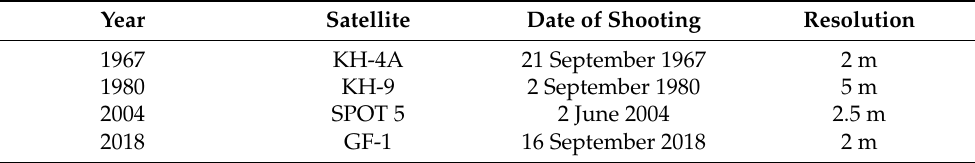
Table 1. Satellite image source.